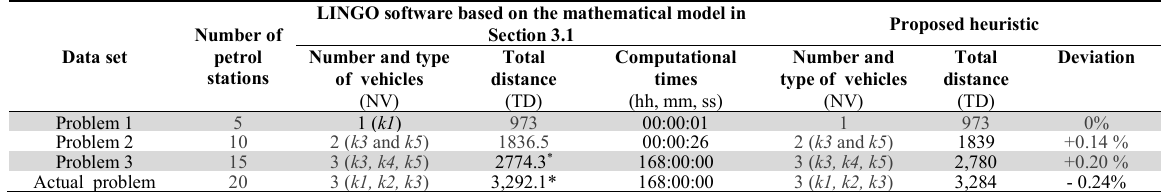
Comparison of solutions using LINGO software and the proposed